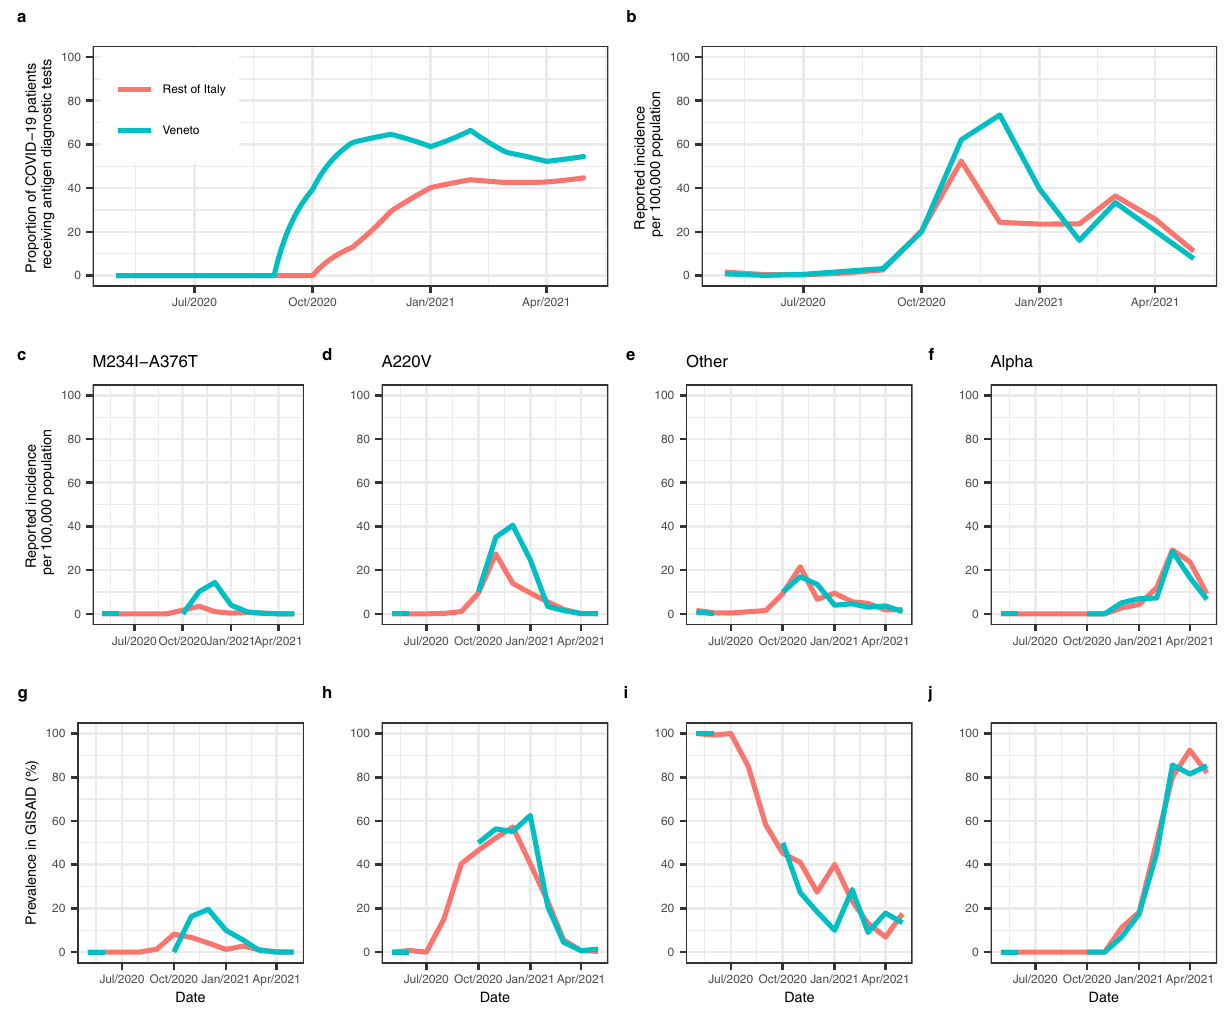
Fig.3|ObservedepidemiologicaldatafromVenetoandtherestofItalyduring the modelling study period. a Proportion of COVID-19 patients receiving antigen diagnostic tests, b total daily reported incidence per 100,000 population, c – f variant-speci fi c daily reported incidences per 100,000 population,